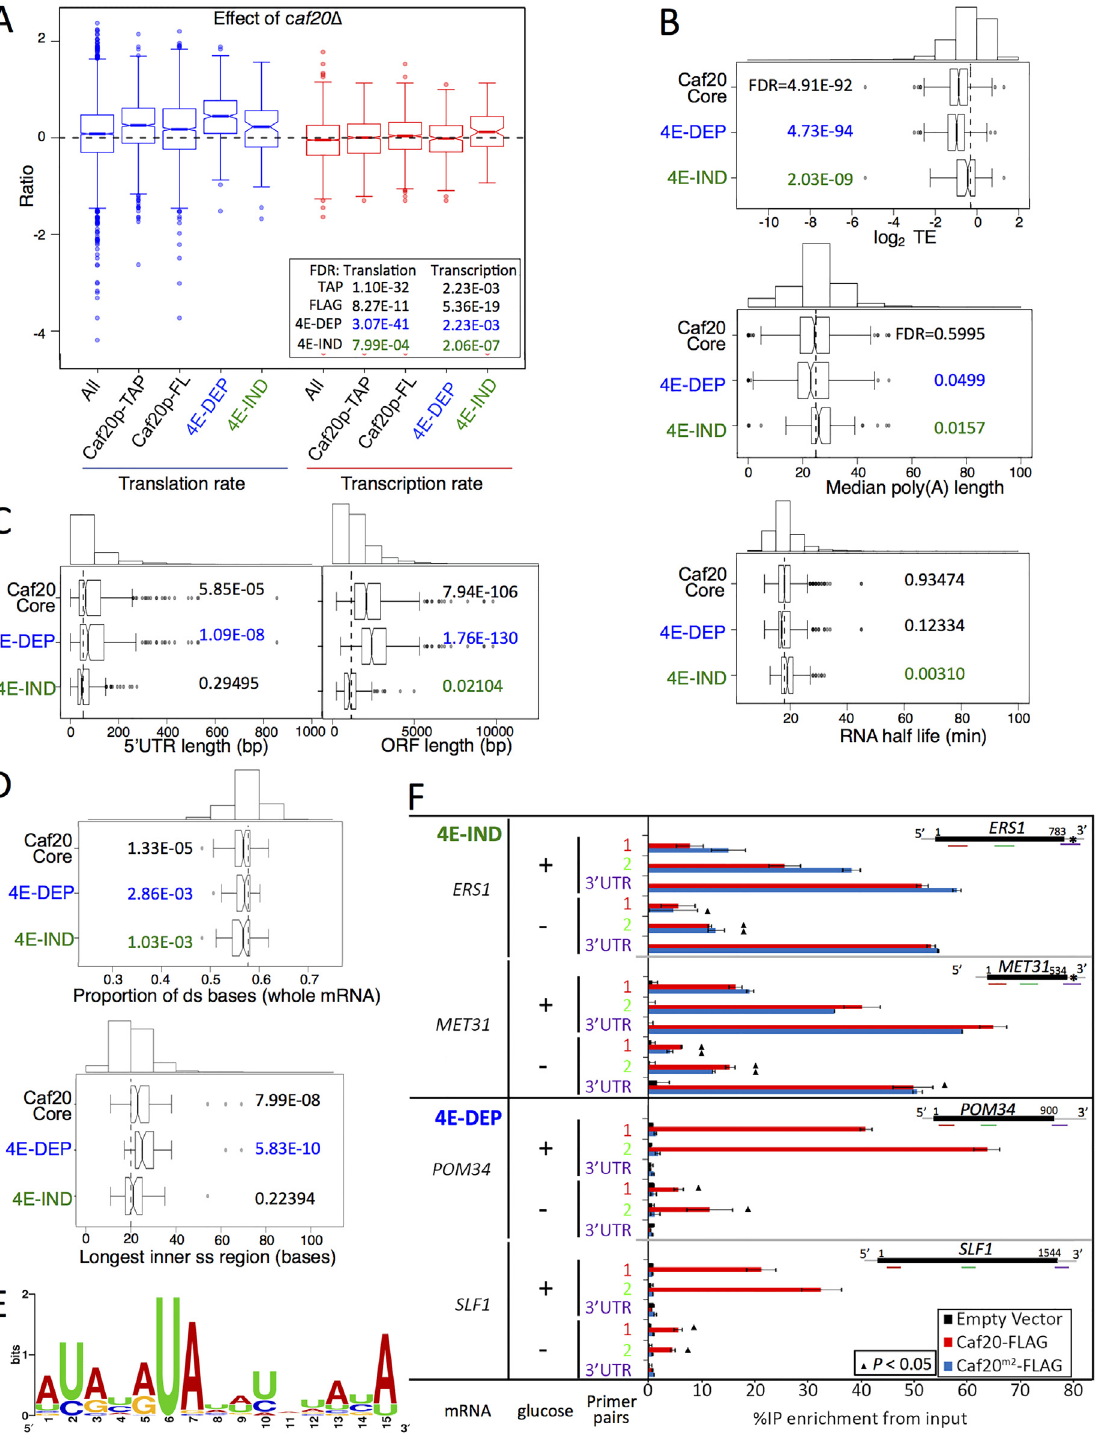
Fig 6. Features of Caf20p 4E-DEP and 4E-IND core bound mRNAs. A. Box and whisker plot showing impact of caf20 Δ on polysome association (blue) and transcript abundance (red) across sets of Caf20p-associated mRNAs [19]. A 95% confidence interval around the median is represented by a notch. Where notches do not overlap the medians are different. Inset: P values represent FDR (Mann-Whitney U tests) versus non-target RNAs. B-D: Box and whisker plots comparing mRNA features of Caf20 core mRNA targets and the 4E-DEP and 4E-IND subgroups. Histograms above each plot show binned total data with the vertical dashed line indicating the median of the total. P values represent FDR (Mann-Whitney U tests corrected for multiple